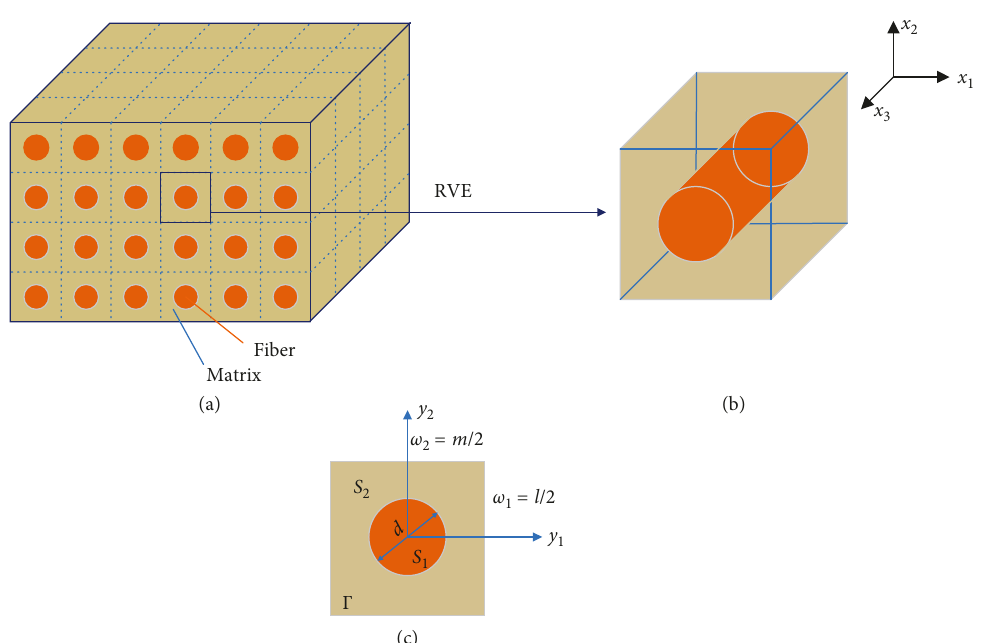
Figure 2: The geometric mode of PCMs: (a) structure, (b) representative volume element (RVE), and (c) transversal cross-section of the